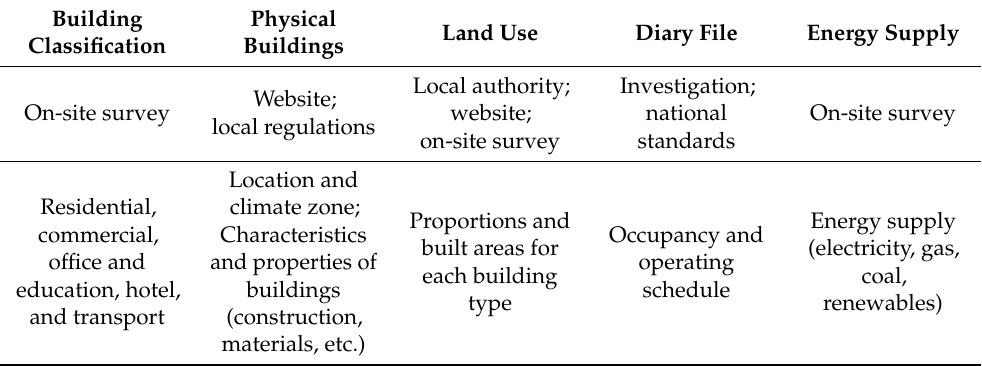
Table 2. Approaches to data collection.